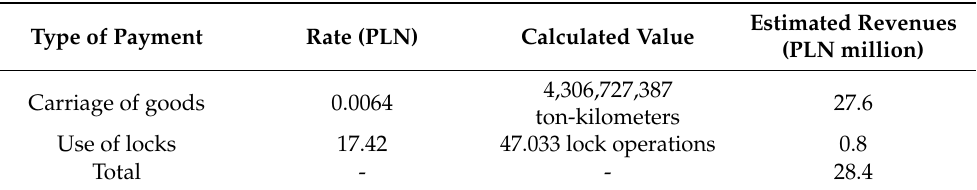
Table 5. Shipping benefits of creating a section of the Lower Vistula waterway downstream from the Włocławek barrage with international